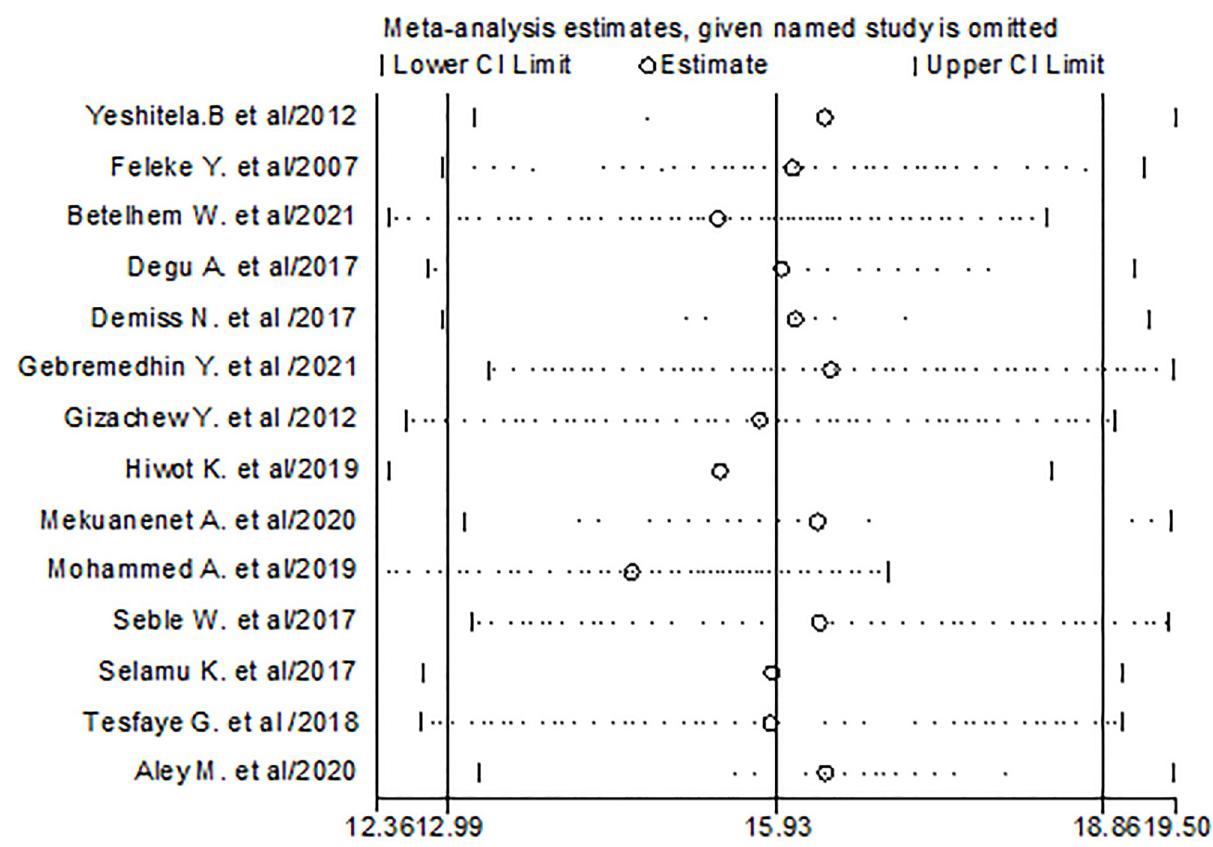
Fig 8. Results of sensitivity analysis of the 14 studies in the meta-analysis of UTI.